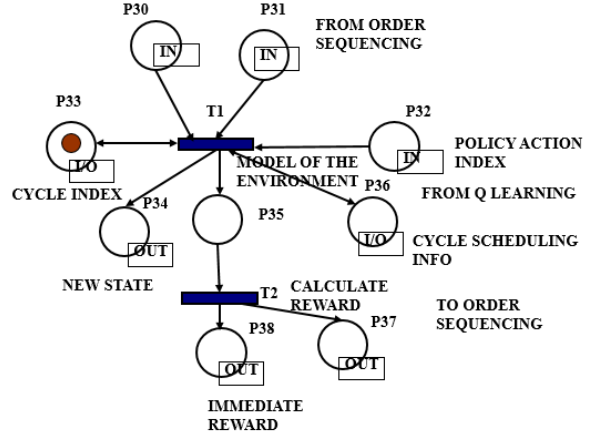
Figure 5. The implemented hierarchical CTPN model of the Perception substitution transition.